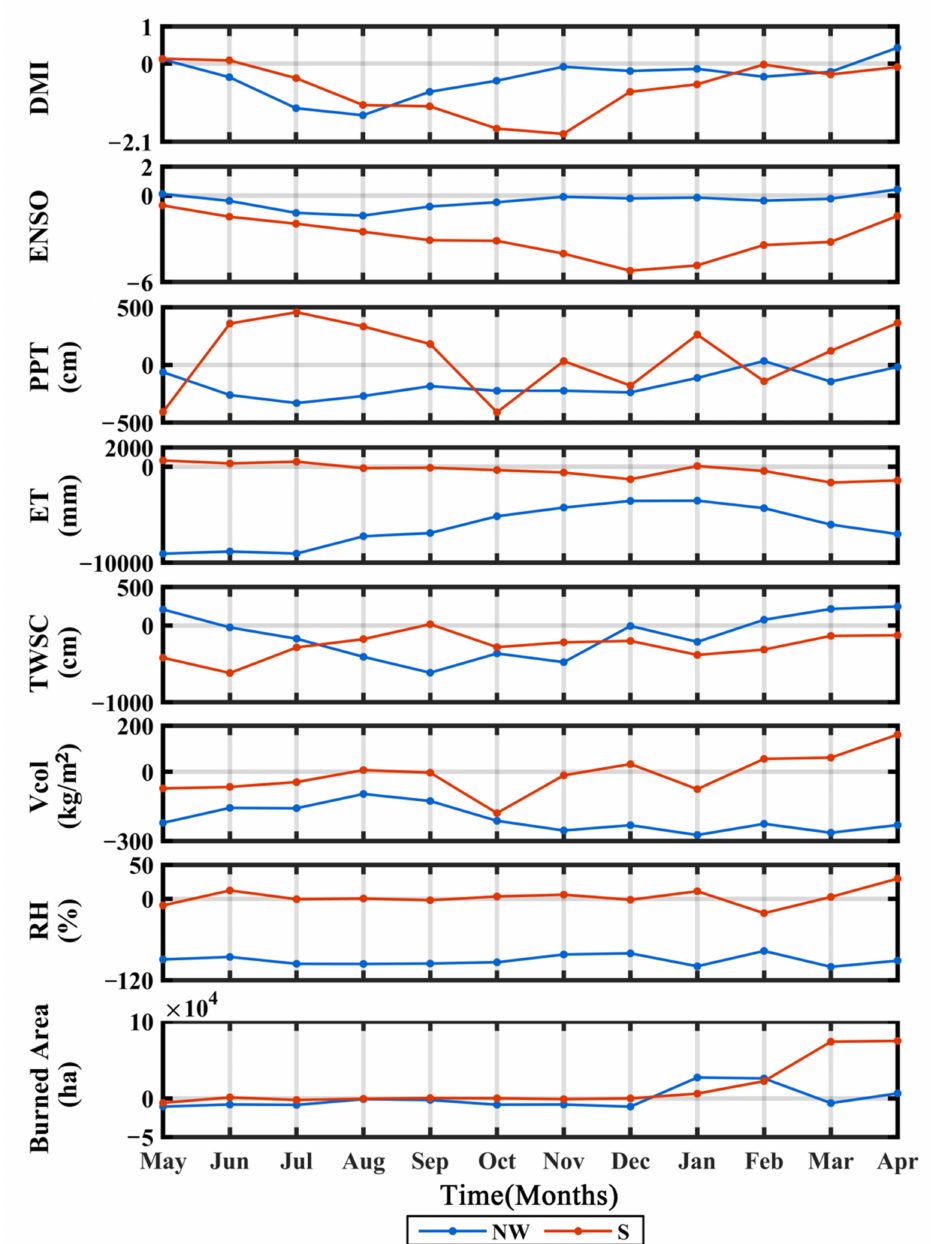
Figure 11. Monthly evolution of Yunnan climate before and during extreme forest fire months. The differences between monthly average of PPT, ET, TWSC, Vcol, RH and burned area in high- and low-fire years (blue line: region NW, red line: region